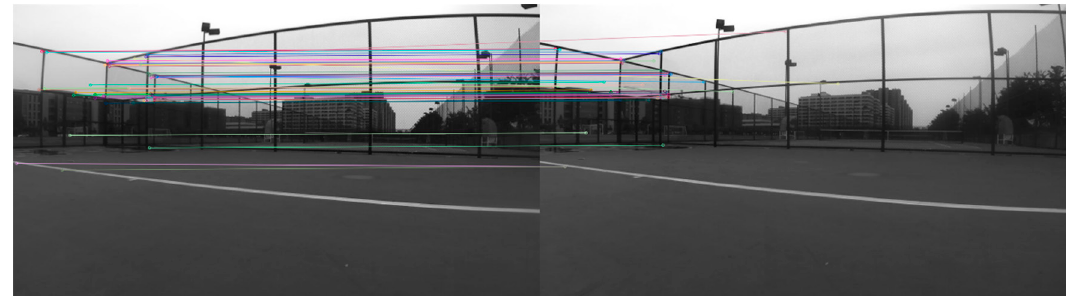
Figure 5. Stereo matching.